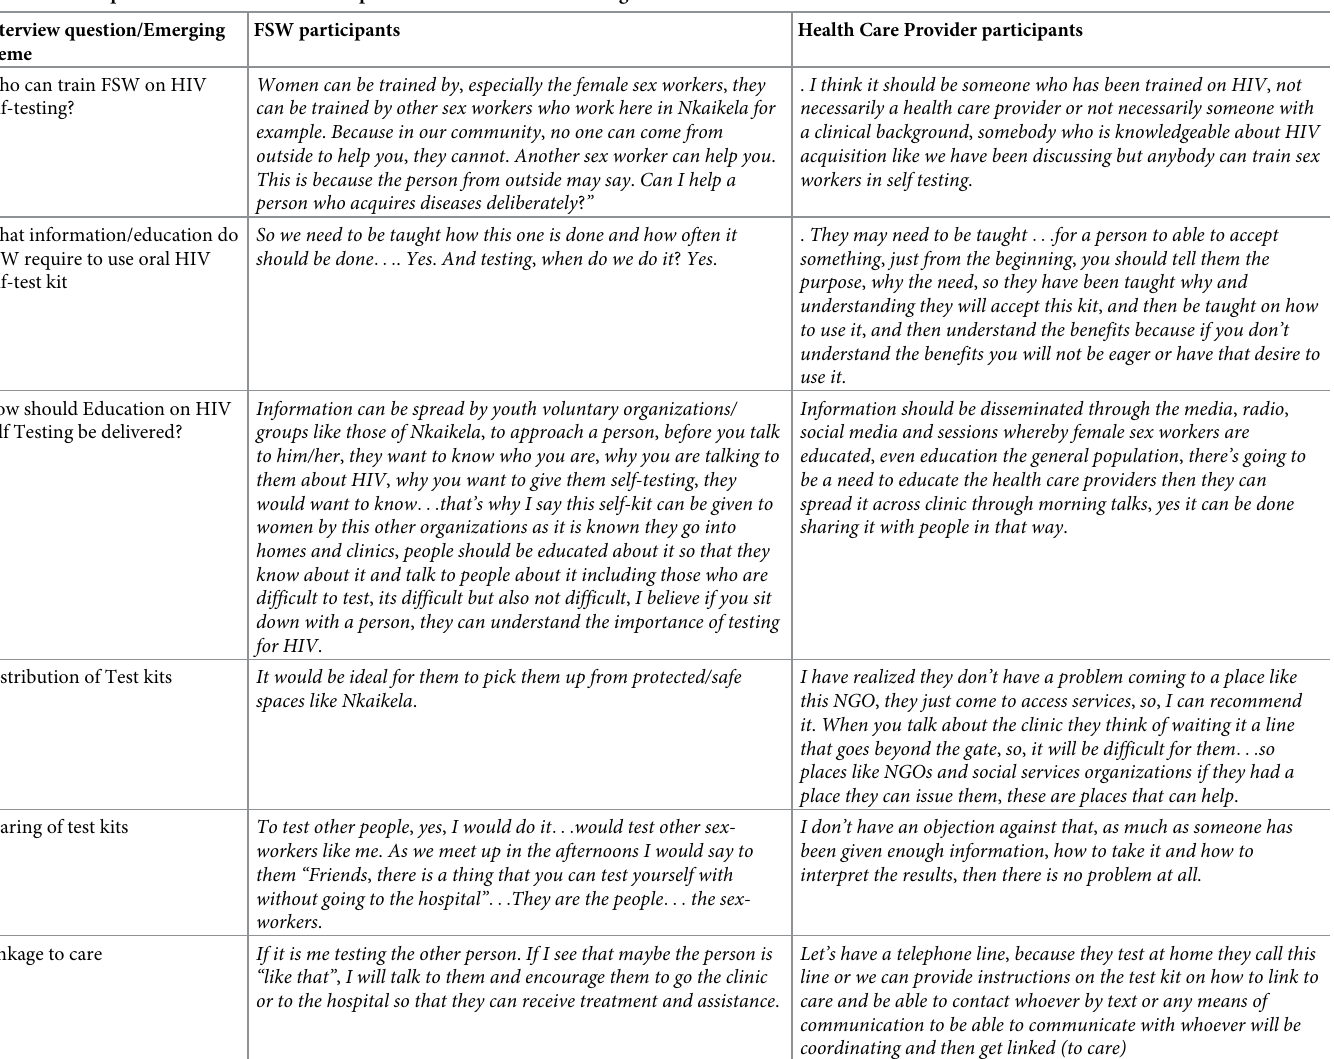
Table 2. Participant recommendations for implementation of HIV-self